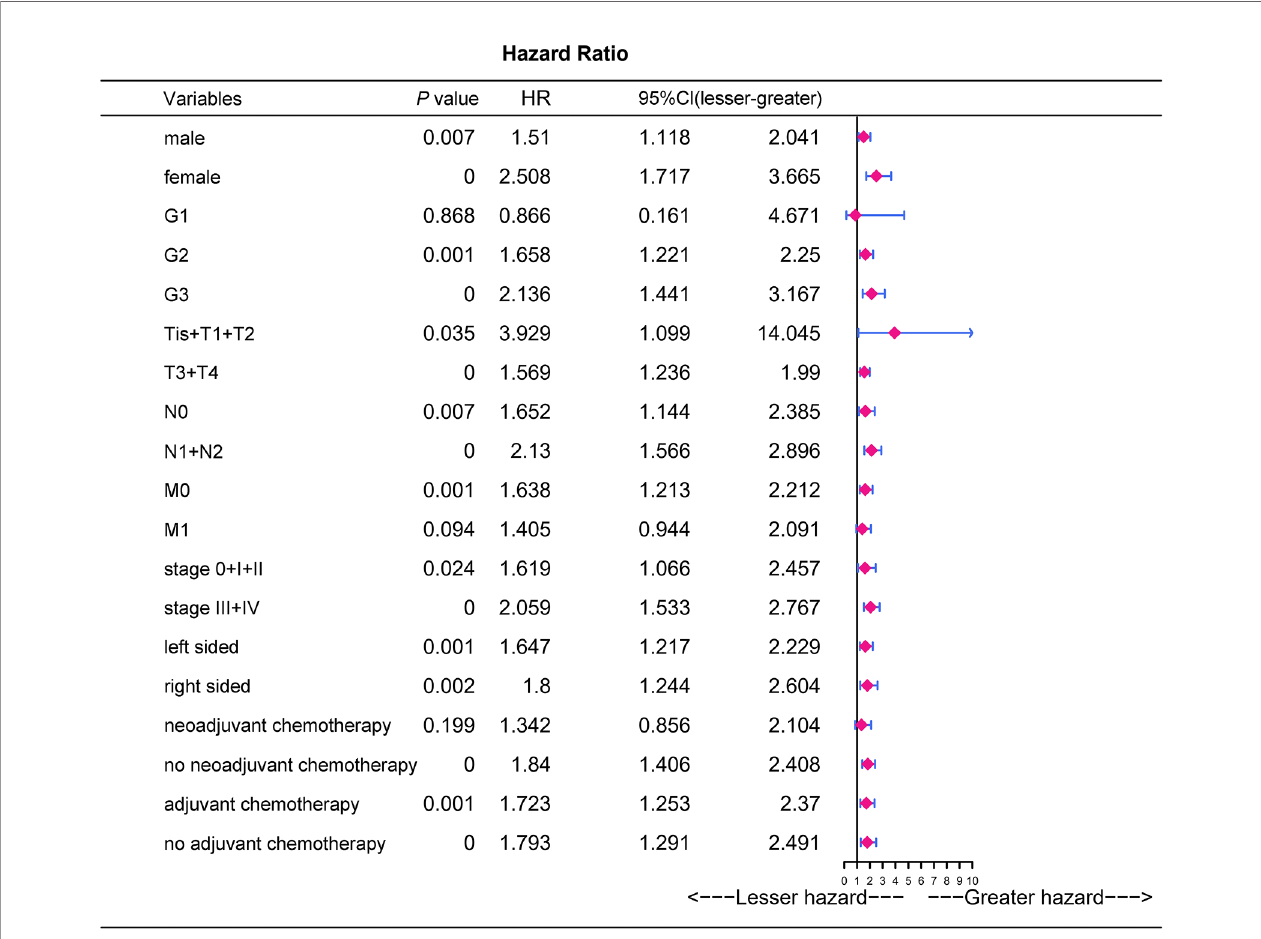
FIGURE 4 | Prognostic analysis of CRP/MCV values in different subgroups. Univariate logistic regression analysis was performed in different subgroups to determine the relationship between CRP/MCV values and prognosis. P value was based on Student ’ s t-test for continuous factors, and on chi-square test (case number ≥ 5) or Fisher ’ s exact test (case number < 5) for categorical factors. CRC, colorectal cancer; CRP, C-reactive protein; MCV, mean corpuscular